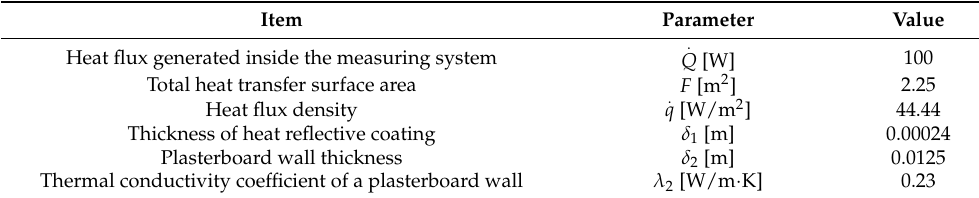
Table 1. Data for the calculation of the equivalent thermal conductivity λ 1 of the heat reflective material tested.